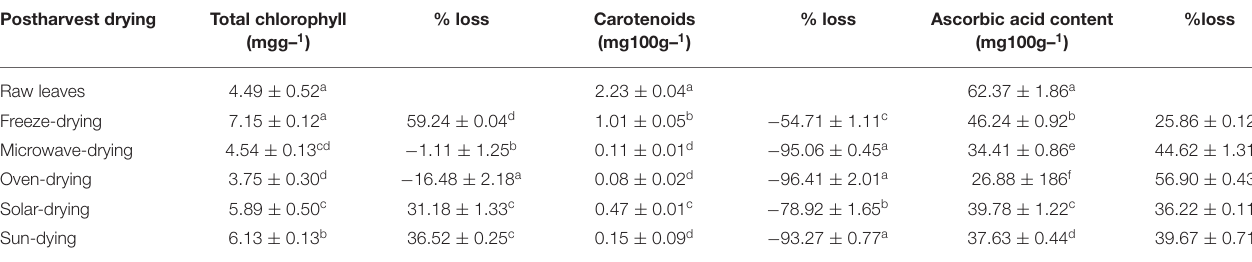
TABLE 2 | Effect of different drying treatments on chlorophylls and total carotenoids in the leaves var. Butternut squash ( C. moschata ). Postharvest drying